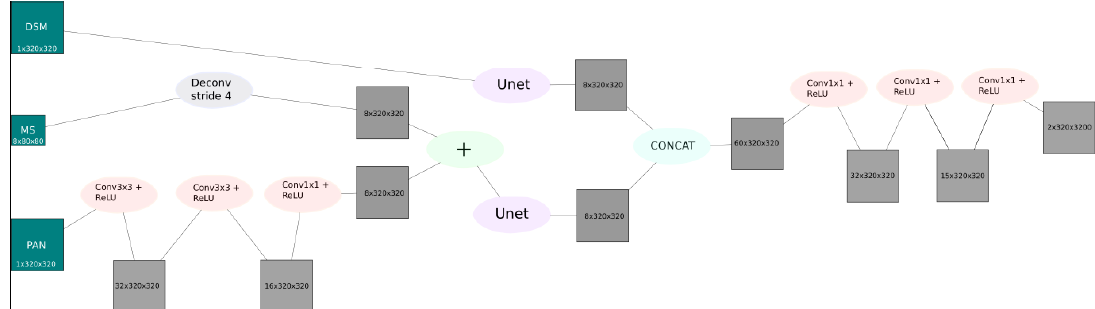
Figure 1. The complete architecture of the proposed network. The architecture consists of three main stages. In the first stage, the multi-spectral image and the pan image are fused by applying a residual neural network block. The pansharpened output image propagates further to the second stage of the proposed architecture corresponding to the Unet. In a parallel stream, the DSM image also goes through the Unet. In the final stage, two branches are merged by CONCAT layer and further propagate to the top layer of the proposed